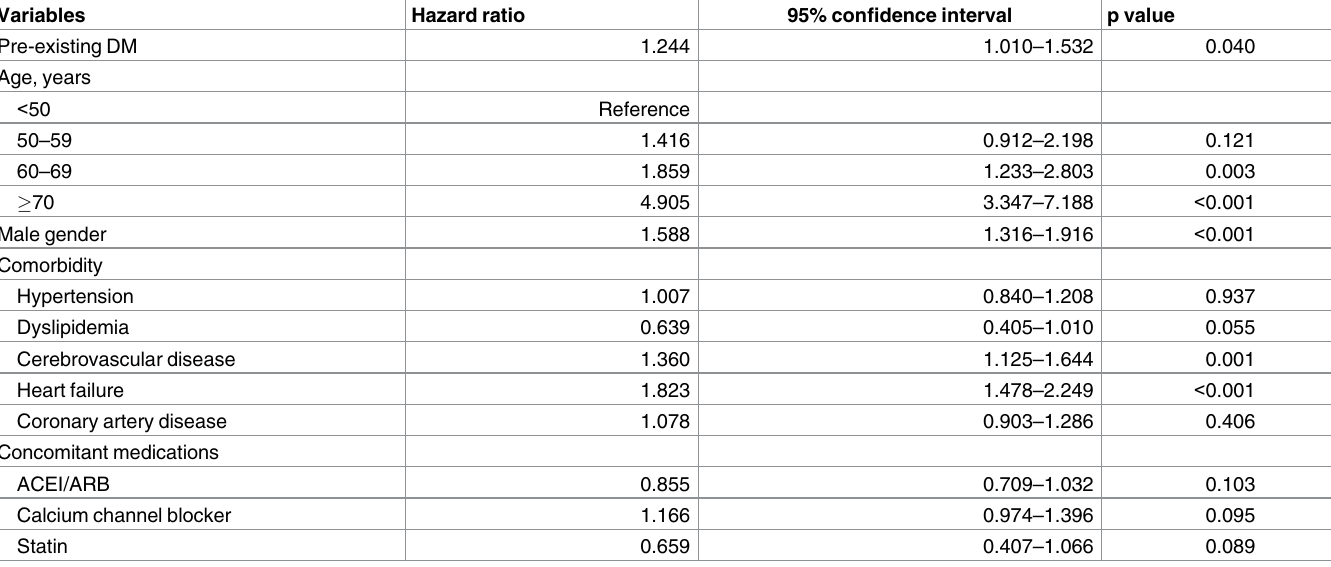
Fig 2. Adjusted Kaplan–Meier curves for survival in all COPD patients with and without pre-existing DM (n = 2015). a Adjustedfor age, gender, comorbidities (hypertension, dyslipidemia, cerebrovascular disease,heart failure, and coronary artery disease)and concomitantmedications (ACEI/ARB, calcium channelblocker, and statin). ACEI, angiotensin-convertingenzyme inhibitor;ARB, angiotensin II receptor blocker; COPD, chronicobstructive pulmonary disease;DM, diabetes mellitus. https://doi.org/10.1371/journal.pone.0175794.g002 groups. Multivariate Cox proportional hazards analysis showed that comorbidities, including hypertension (HR, 1.810; 95% CI, 1.363–2.403), cerebrovascular disease (HR, 1.517; 95% CI, 1.146–2.008), and coronary artery disease (HR, 1.408; 95% CI, 1.089–1.820), were independent clinical factors associated with development of incident DM (Table 4). Compared with the Table 2. Multivariate Cox proportional hazards model for mortality in all COPD patients (n =